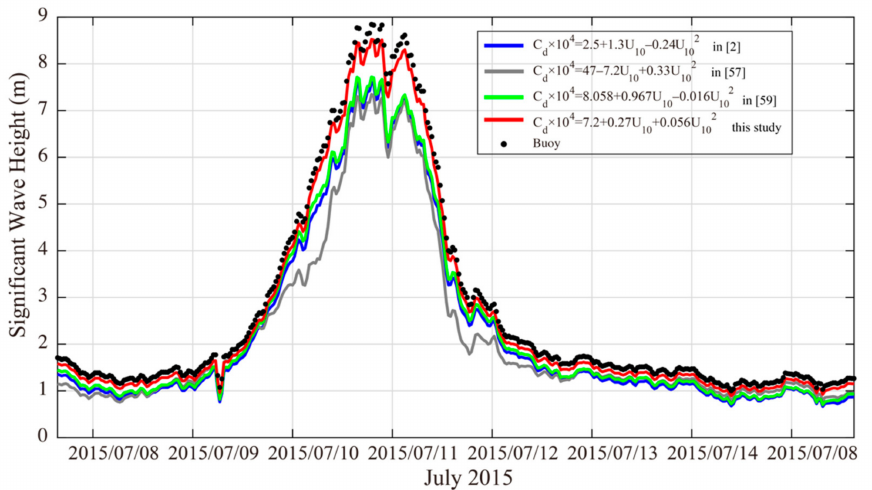
Figure 9. The comparisons of the WW3-simulated H s using the models adapted from in [2] (blue line), [57] (gray line), [59] (green line), and this study (red line) with the measurements from the buoy station (122.745 ◦ W, 29.750 ◦ N) in July during Typhoon Chan-hom